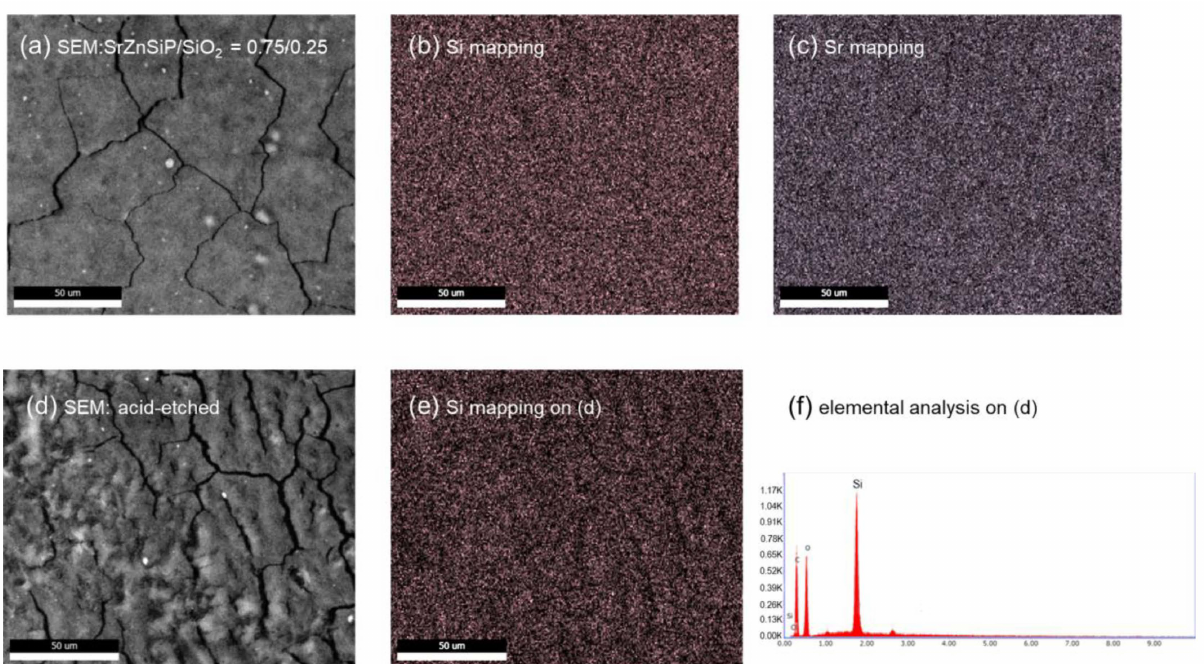
Figure 10. Mapping analyses by SEM/EDS on the coating surfaces of a mixture of SrZnSiP and SiO 2 (0.75/0.25). ( a ) SEM image; ( b ) Si mapping; ( c ) Sr mapping; ( d ) SEM image after acid treatment; ( e ) Si mapping of ( d ); and ( f ) elemental analysis of ( d